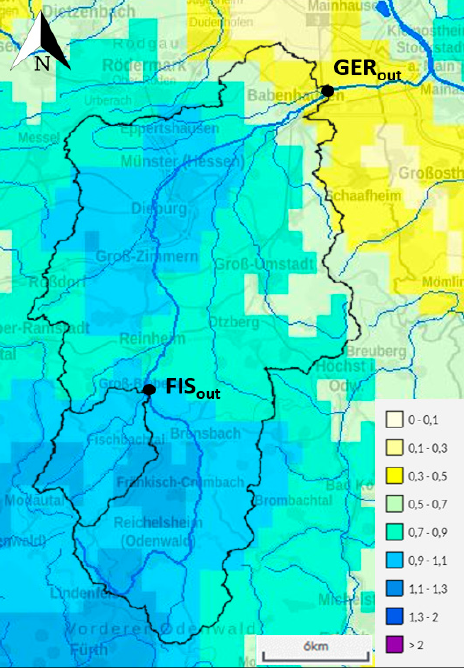
Figure 2. Drainage density in the Gersprenz (GER) and Fischbach (FIS) in km/km 2 (data source: BfG [38]).